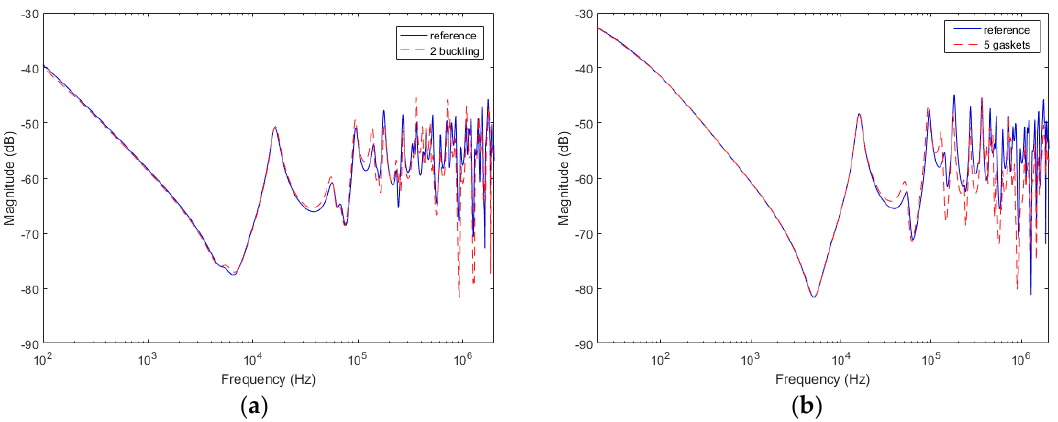
Figure 7. FR curves of the experiment: ( a ) an example of radial buckling; ( b ) an example of axial displacement.